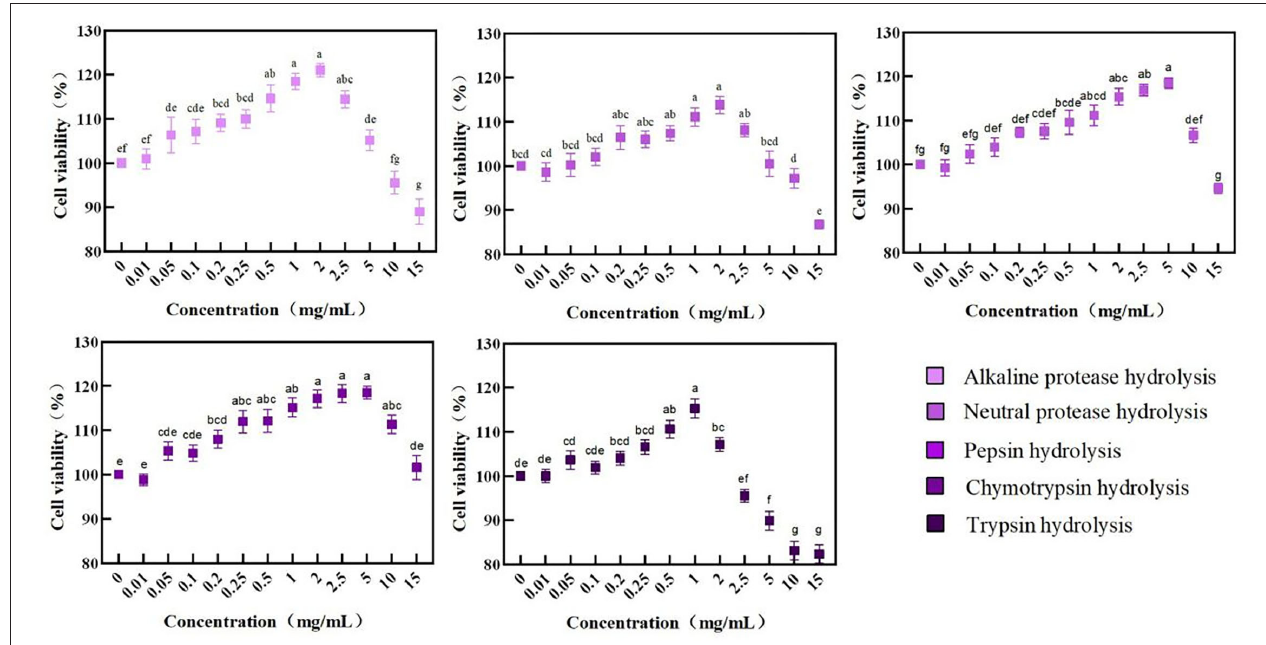
FIGURE 3 | Cell viability of Caco-2 cells treated with BRPHs. Results are expressed as means ± SD ( n = 4). Different letters (a–g) the picture indicate statistically significant differences ( p < 0.05).